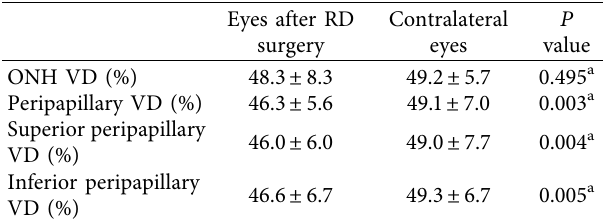
Table 3: Characteristics of ONH region in RRD eyes and fellow eyes using OCTA three months after PPV